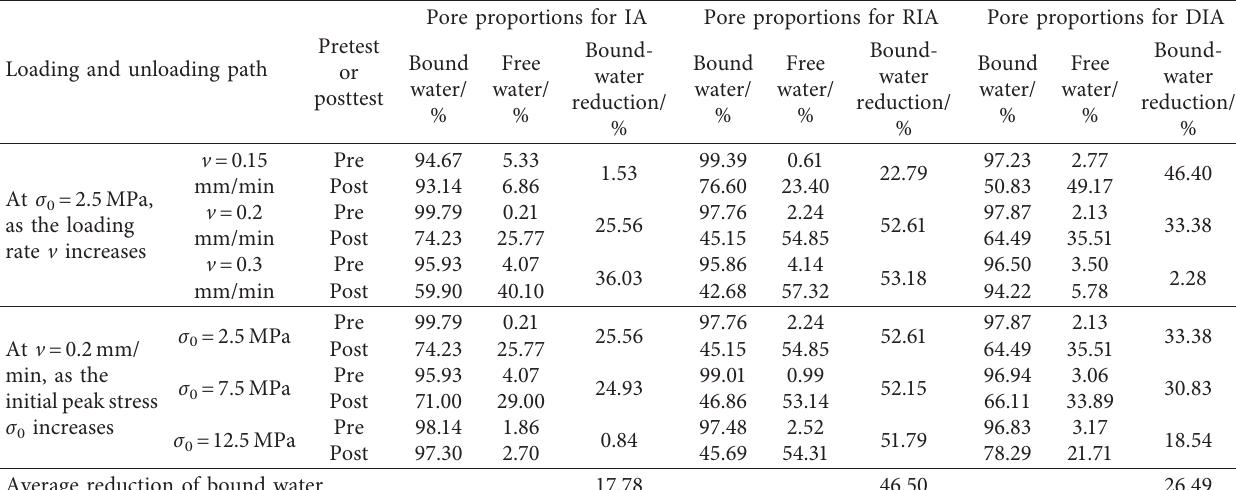
Table 7: Distributions of bound water and free water before and after loading and